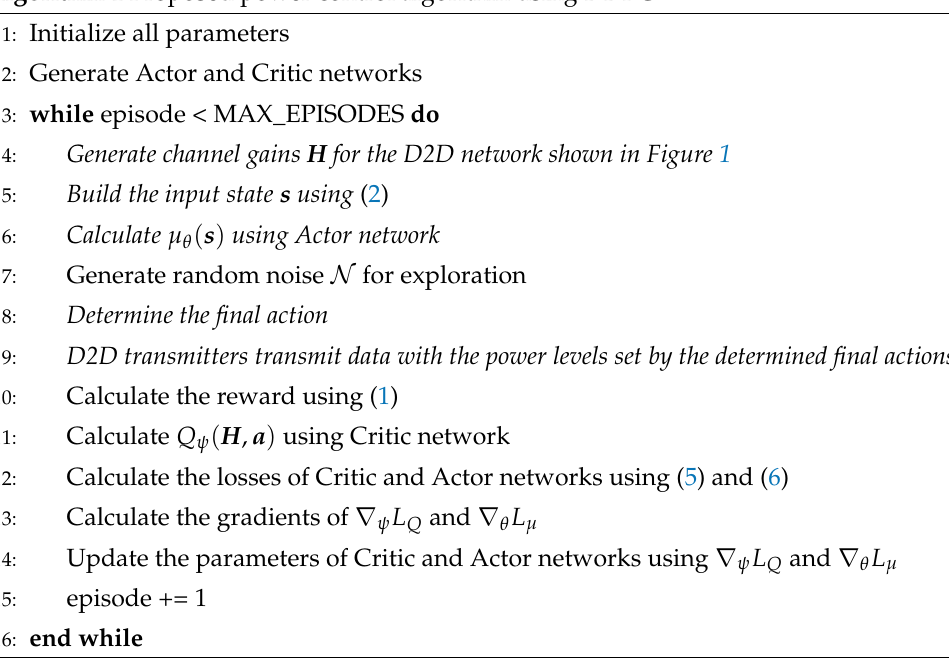
Algorithm 1 Proposed power control algorithm using